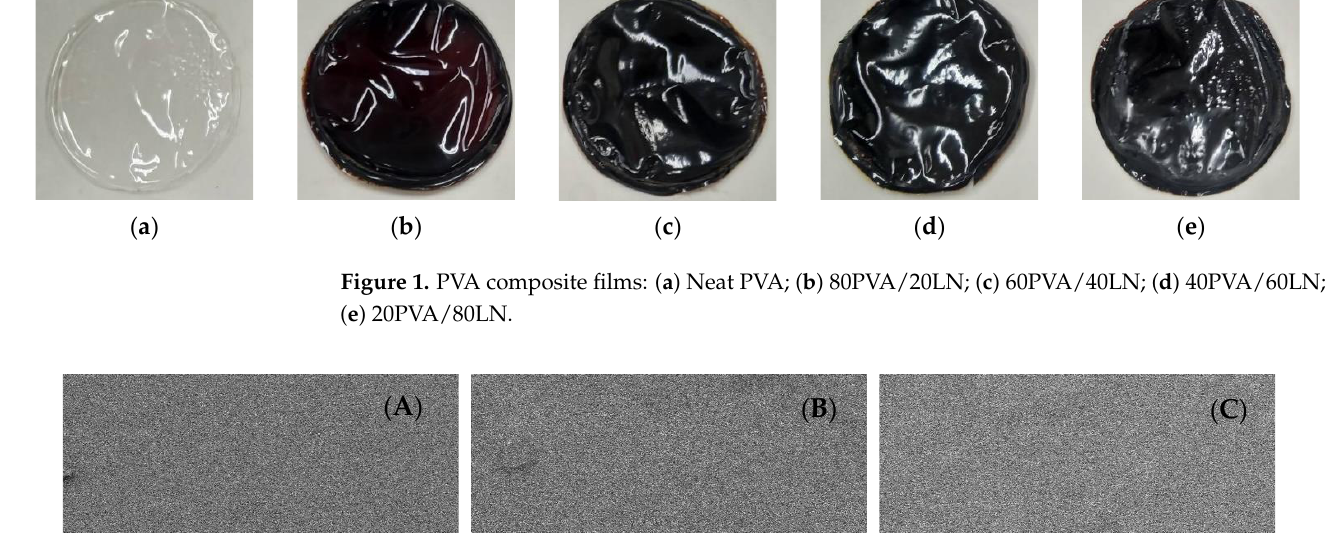
Figure 1. PVA composite films: ( a ) Neat PVA; ( b ) 80PVA/20LN; ( c ) 60PVA/40LN; ( d ) 40PVA/60LN; ( e ) 20PVA/80LN.